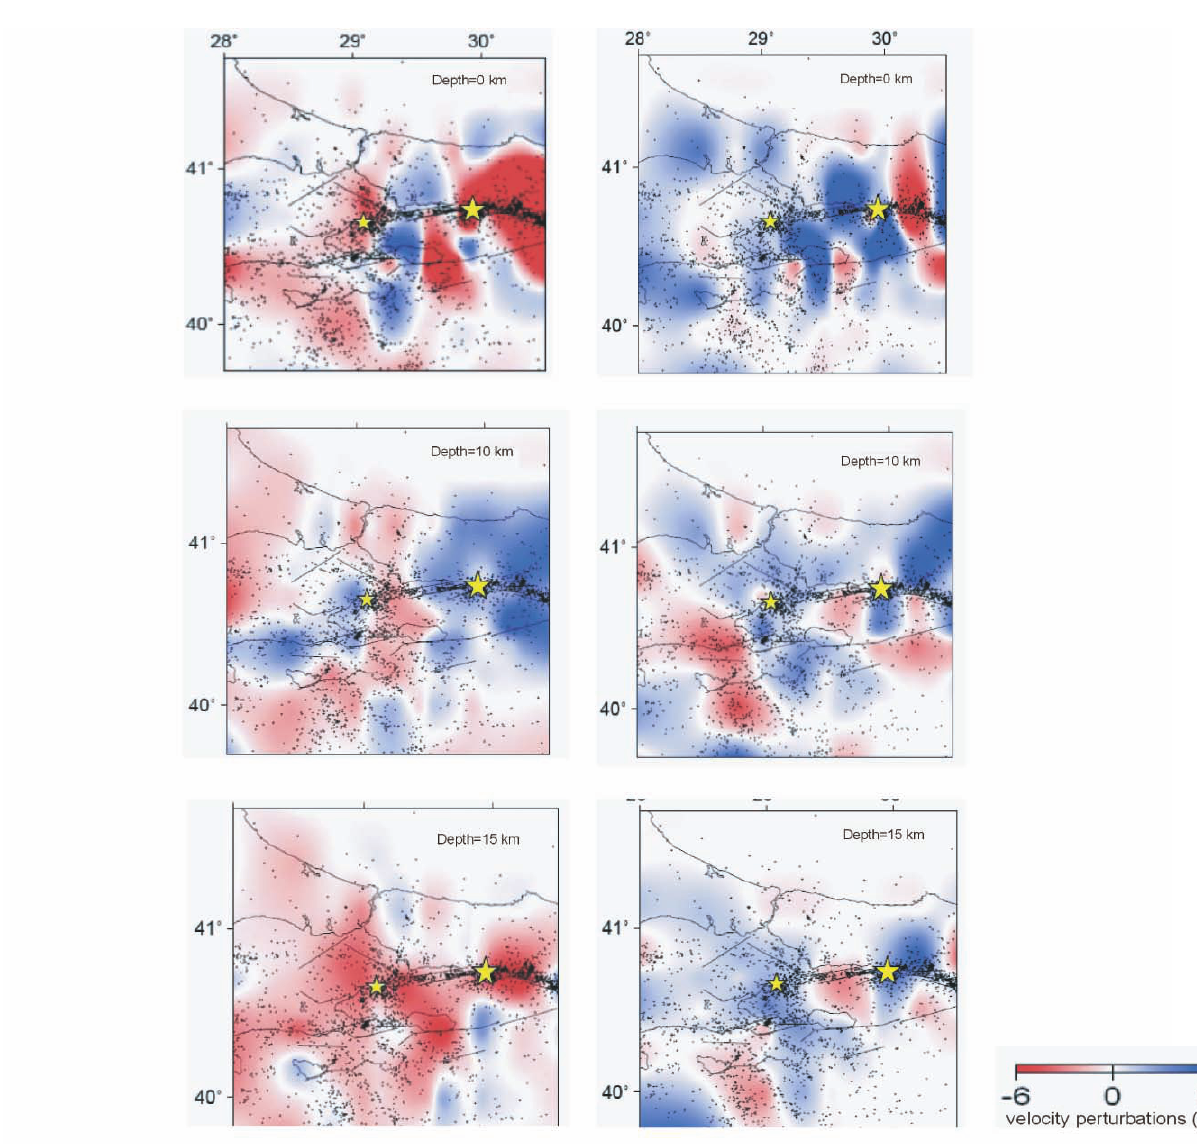
=5.2 Gemlik earthquake. L